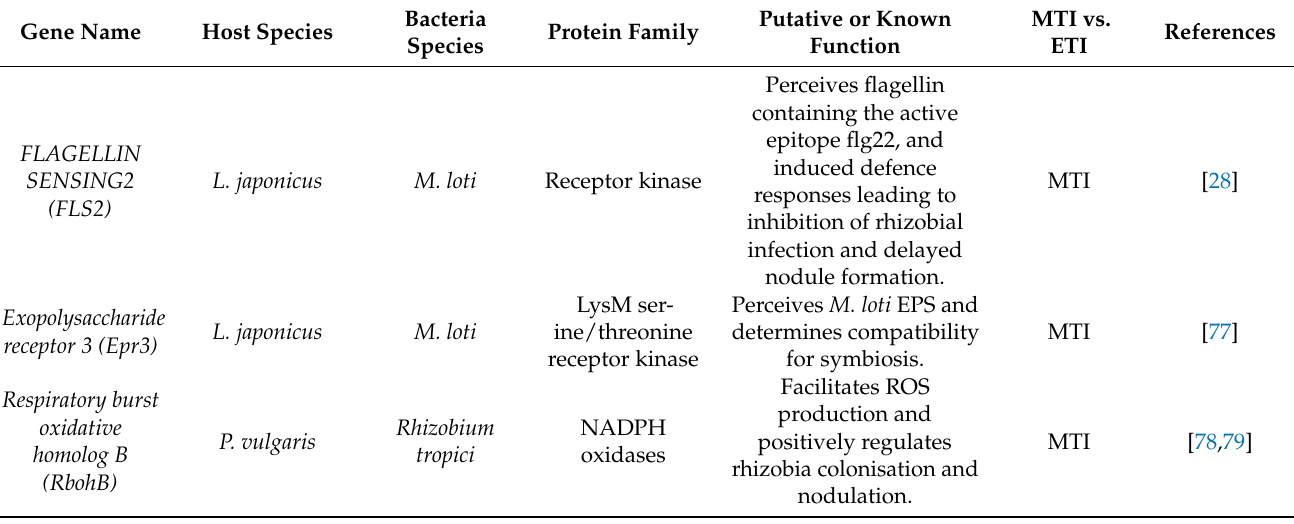
Table 1. Legume resistance proteins currently identified or proposed to function within MTI or ETI, demonstrating a known effect on or role in